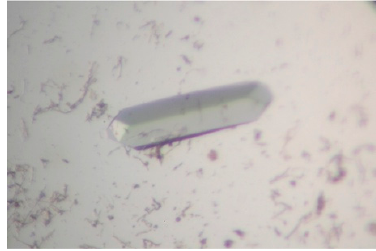
Figure 6. Crystals of the HT-hTS variant R175C.